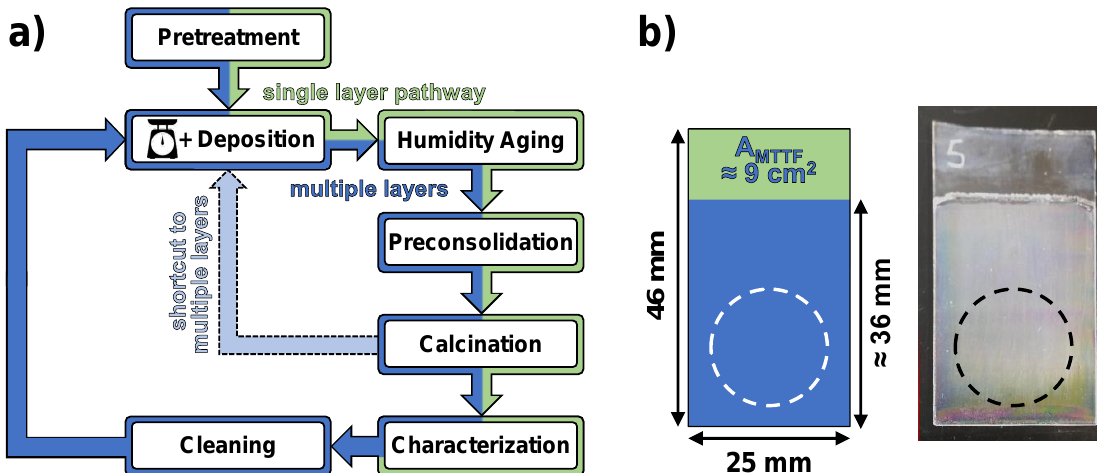
Figure 1. ( a ) Flowchart of steps involved in the film preparation. Green and blue arrows represent pathways to single- and multi-layered MTTFs, respectively. The pale blue arrow indicates a shortcut by skipping characterization/cleaning of MTTFs. ( b ) Scheme and photograph of a TiO 2 thin film. Green and blue areas represent the bare FTO and TiO 2 part, respectively. The circle indicates the region where electrodeposition might take place later; but more importantly, where optical spectroscopy and photoelectrochemistry are